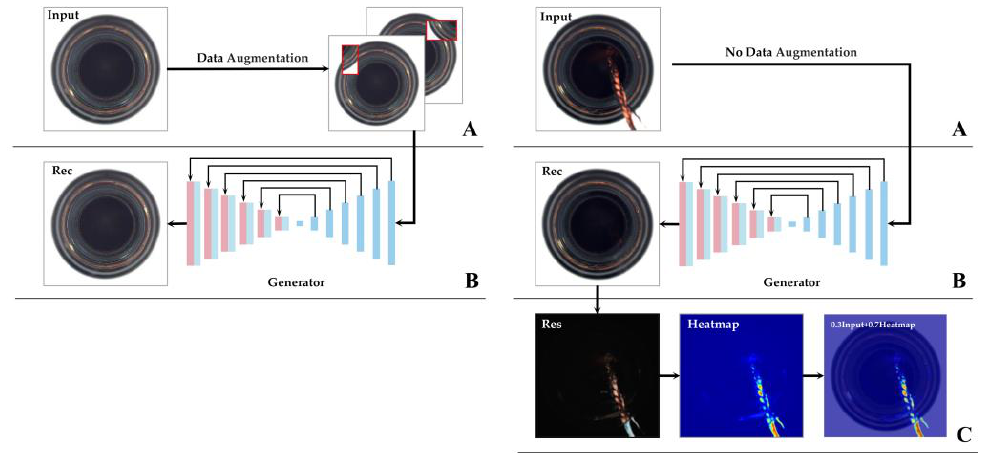
Figure 1. On the left , A is the image enhancement process and B is the image reconstruction process. Generators learn only normal image features. On the right , A indicates that the image has not been data enhanced. B is the reconstruction process of the test image. C represents the absolute residual between the reconstructed image and the test image, and the residual image is obtained. Finally, the thermal map is generated according to the residual image, and a 0.7 times thermal map is superimposed on the 0.3 times abnormal image to complete the abnormal location of the image.